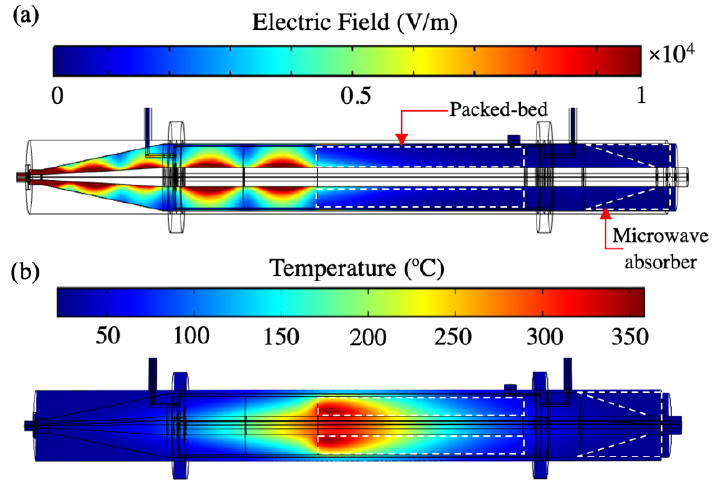
Figure 5. (a ) Temperature and ( b ) Electric field distribution after 80 min in the reactor loaded with β‐ SiC under 60 W microwave power input.